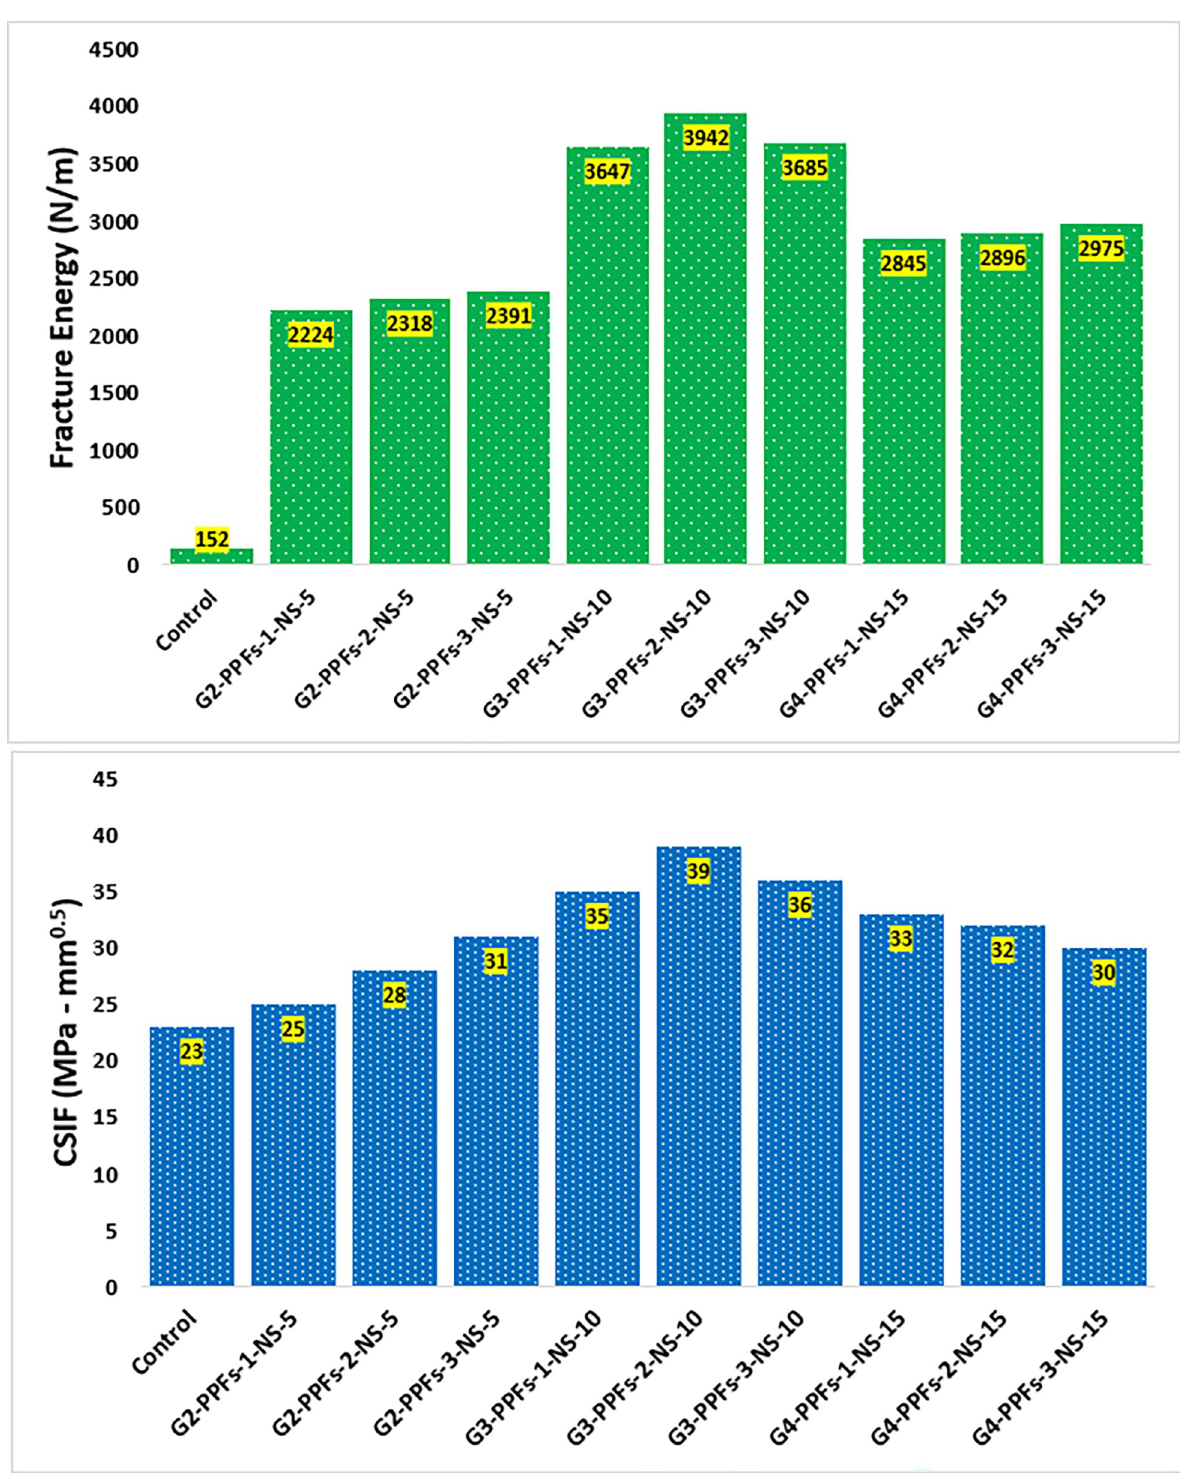
Fig 18. (a) Impact of PPFS and NS on UHS-GPC’s fracture energy, (b) Impact of PPFS and NS on UHS-GPC’s CSIF.